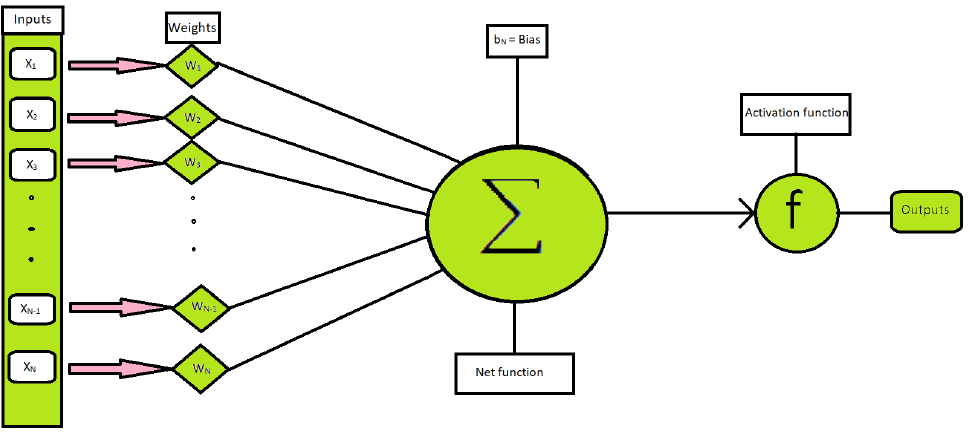
Figure 2. Basic design of a neural network.